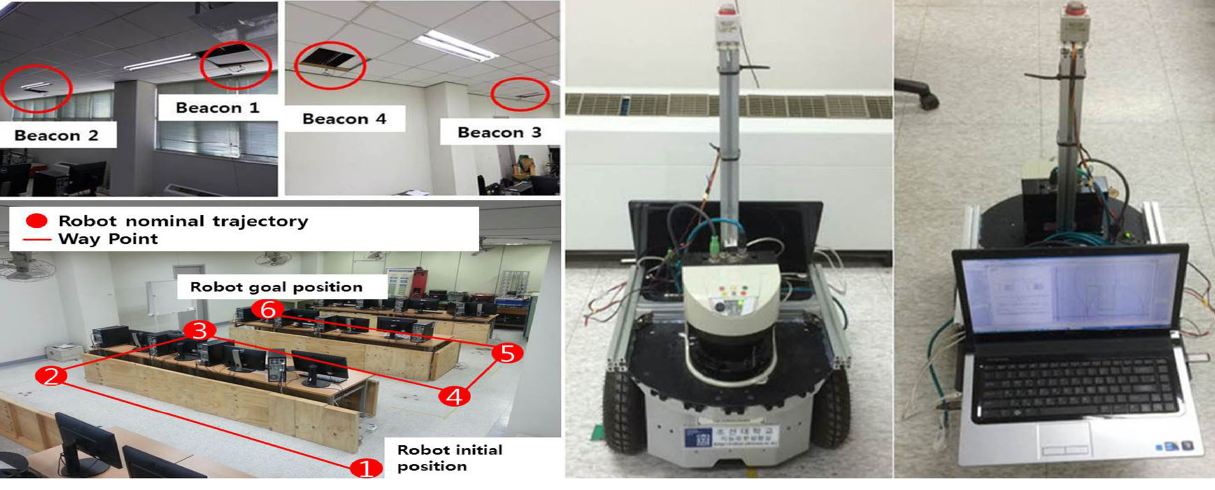
Figure 1. Set up of the experiment: robot, sensors and work area.